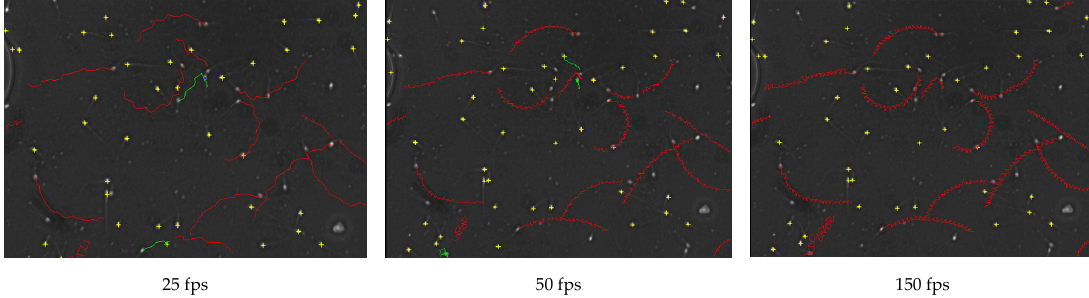
Figure 3. Donkey sperm motility tracks at different frames (25, 50 and 150), exhibiting 4 groups of spermatozoa velocity: rapid (red), medium (green), slow (blue) and static (yellow) in D4C10 chamber, fps = frames per second.